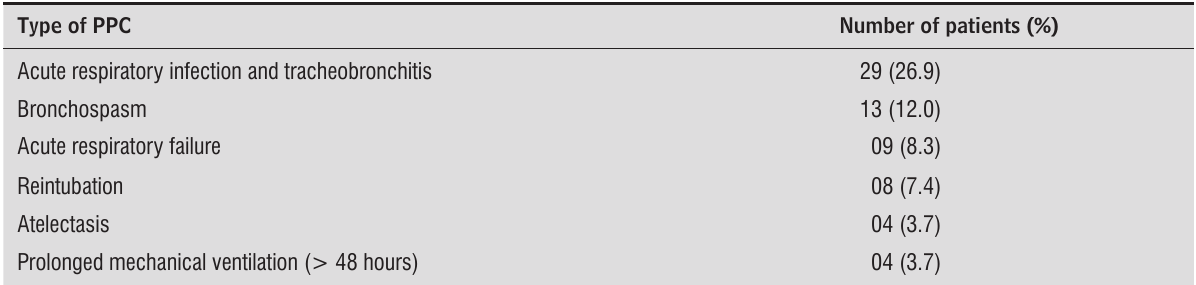
Table 3 - Distribution of PPCs observed while monitoring of patients